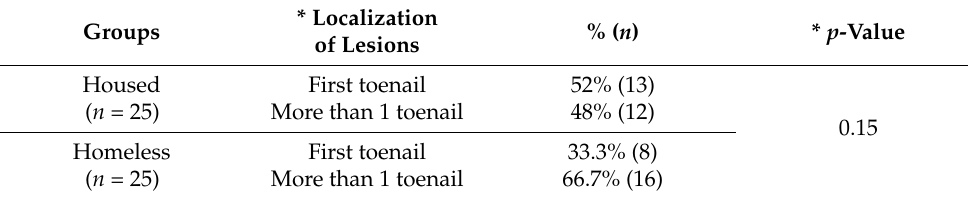
Table 3. Results of relationship between mycotic lesion location and study group ( n =